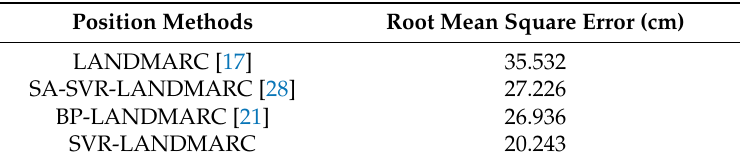
Table 2. Comparisons of SVR-LANDMARC with different positioning methods.